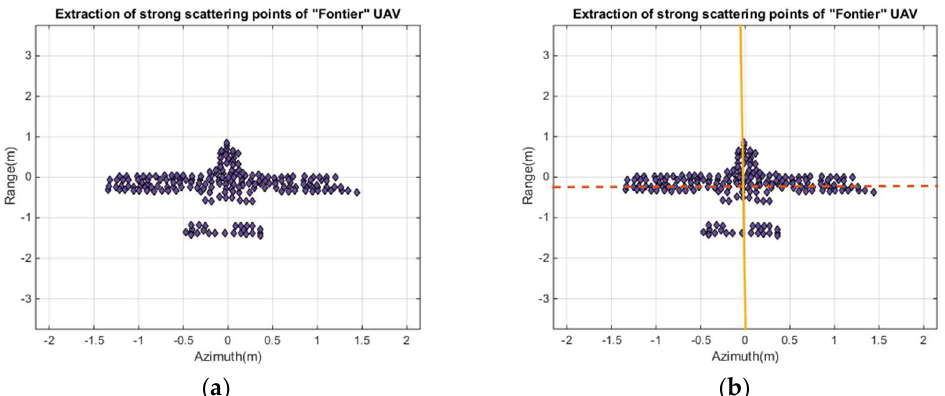
Figure 8. The extraction of scattering centers and the size estimation of “Frontier” UAV. ( a ) Extraction of scattering centers in the image of “Frontier” UAV; ( b ) Orientations of length and width of “Frontier” UAV.